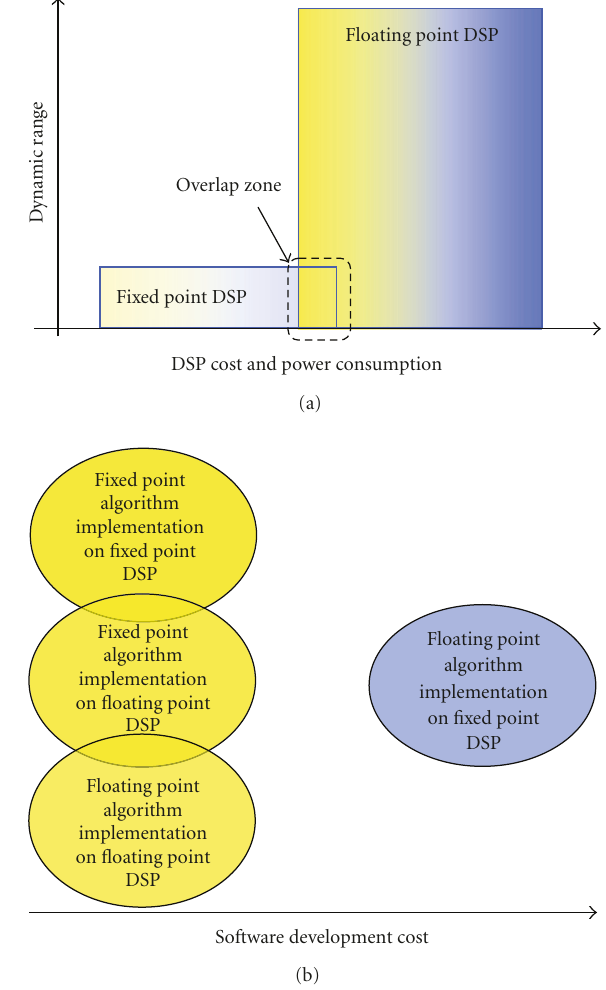
Figure 2: Fixed point and floating point DSP pros and cons.